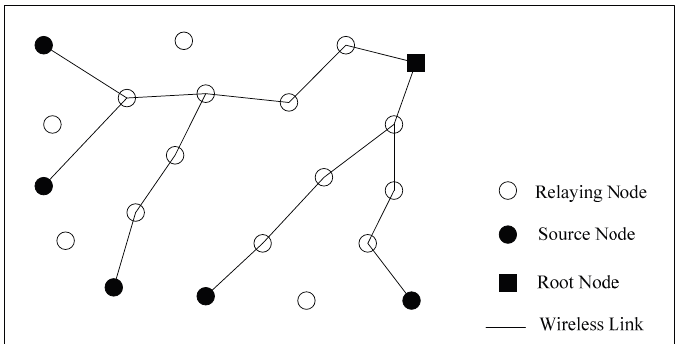
Figure 1. Network model